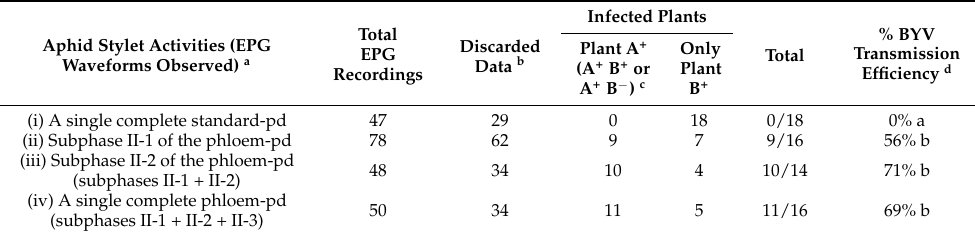
Table 1. Relationship between Myzus persicae stylet activities in sugar beet and inoculation efficiency of Beet yellows virus .